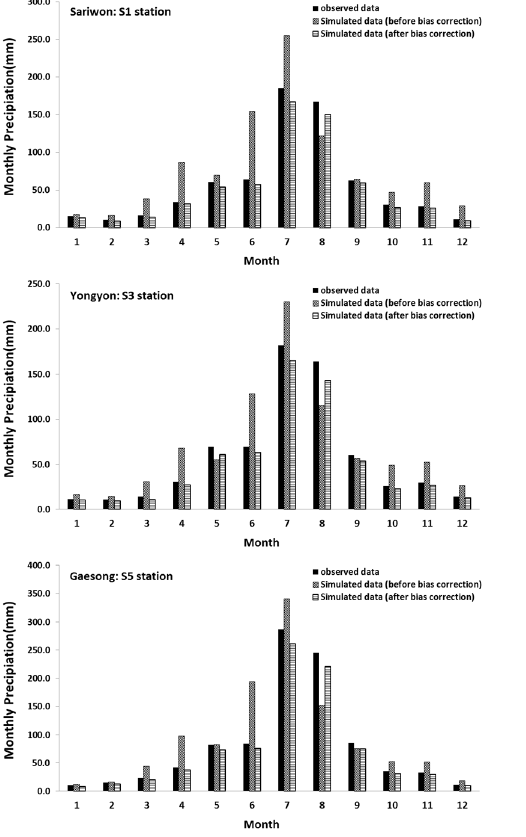
Figure 3. Observed and simulated monthly precipitation in each meteorological station from 1981 to 2005. to